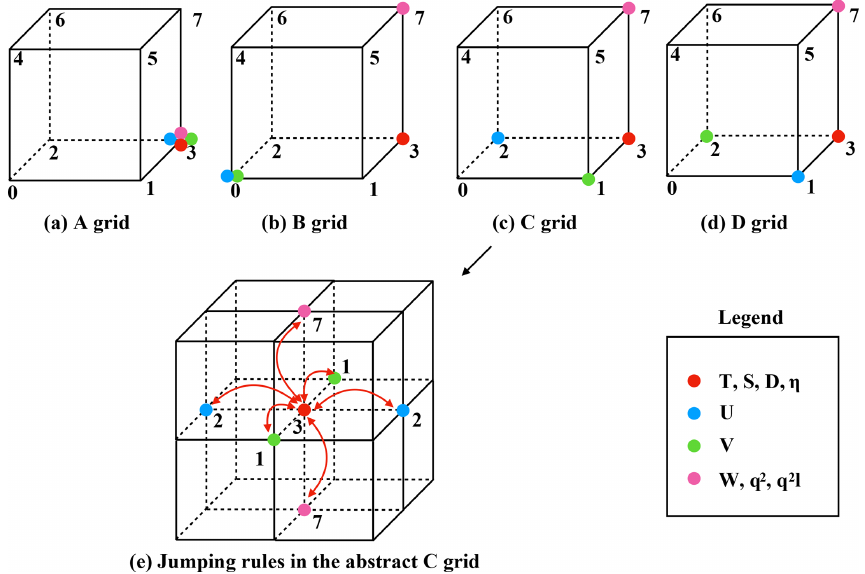
Figure 4. The schematic diagram of the relative positions of the variables on the abstract staggered grid and the jumping procedures among the grid